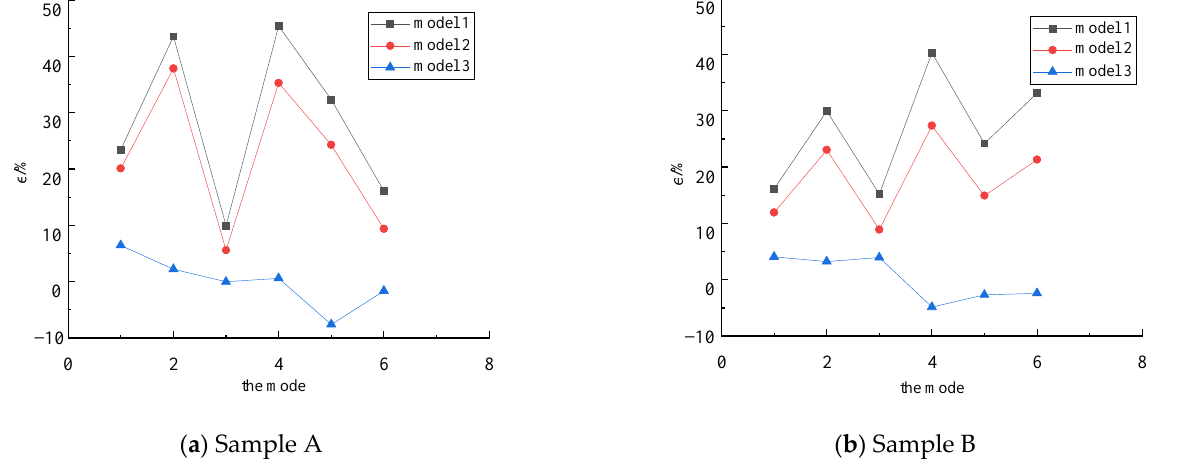
Figure 6. Relative error of natural frequency calculated by finite element model.